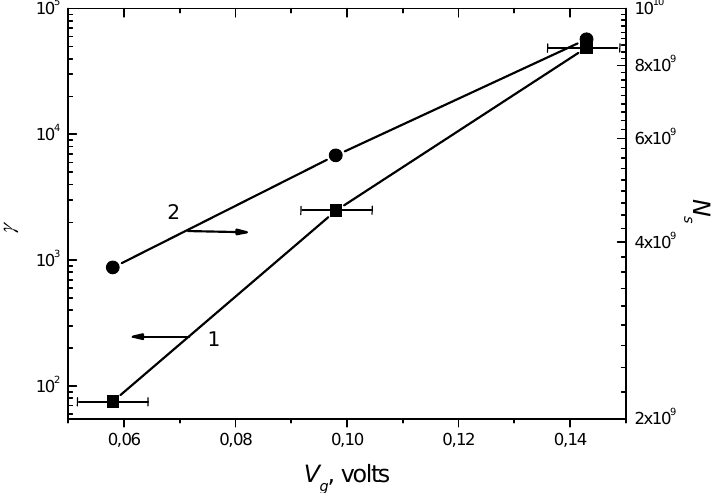
Figure 6. Dependences of parameter  (curve 1) and adsorbed number of particles, N (curve 2) on the gate voltage V . Error bars represent confidence g